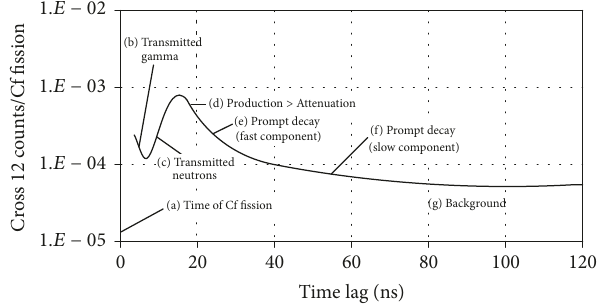
Figure 2: Correlation function between 252 Cf source and a detector ( 𝜏 > 0 ).